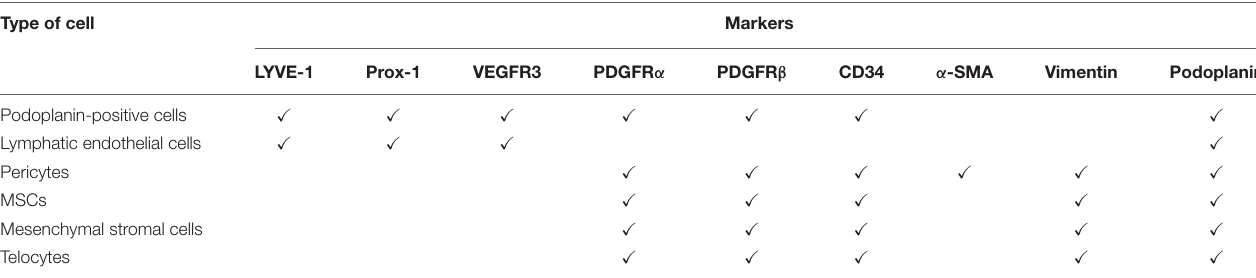
TABLE 1 | Podoplanin-positive cells markers. Type of cell